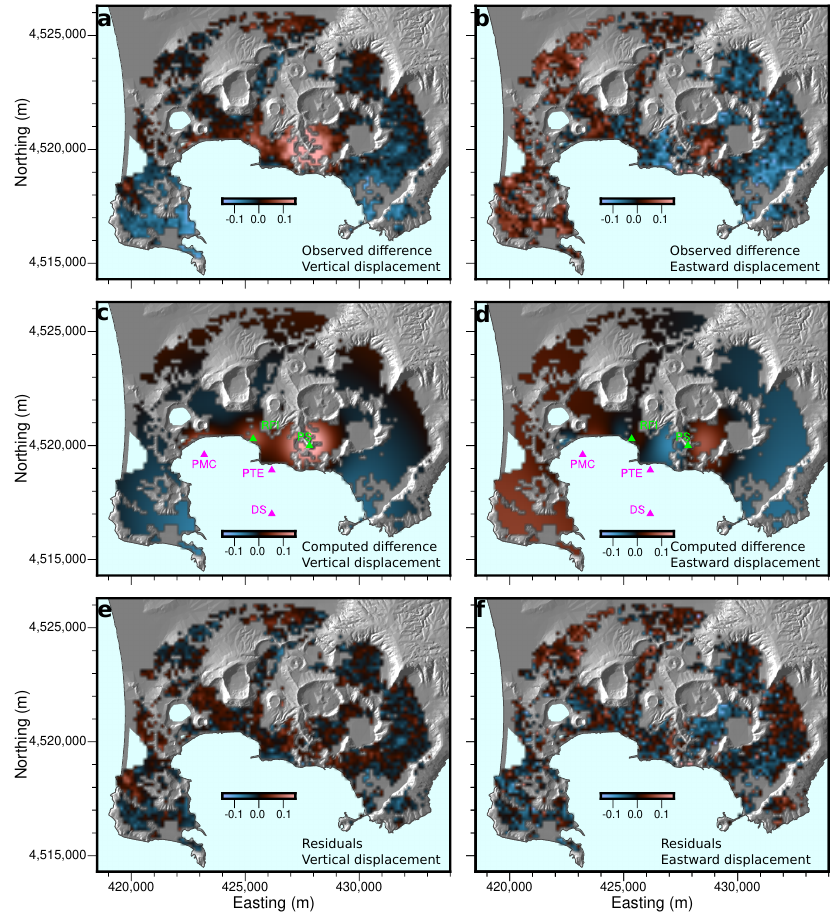
Figure 8. Modeling of the differences between the 1993–2000 and 2015–2022 normalized EOFs. − ˜ h v − ˜ h e ( a , b ) Difference between normalized EOFs ( ˜ h v and ˜ h e in Equation (3), respectively), redrawn 2 2 1 1 from Figure 7e,f for clarity. ( c , d ) Computed cumulative contribution of the PS, RFI, PMC, PTE and (cid:0) (cid:1) v − a a 1, k / r v f v DS deformation sources to the difference between normalized EOFs, i.e., ∑ 5 2, k / r k = 1 2 1 k (cid:0) (cid:1) v − a a 1, k / r v f e and ∑ 5 in Equation (3), respectively. ( e , f ) Model residuals, i.e., differences of 2, k / r k = 1 2 1 k the left and right side of Equation